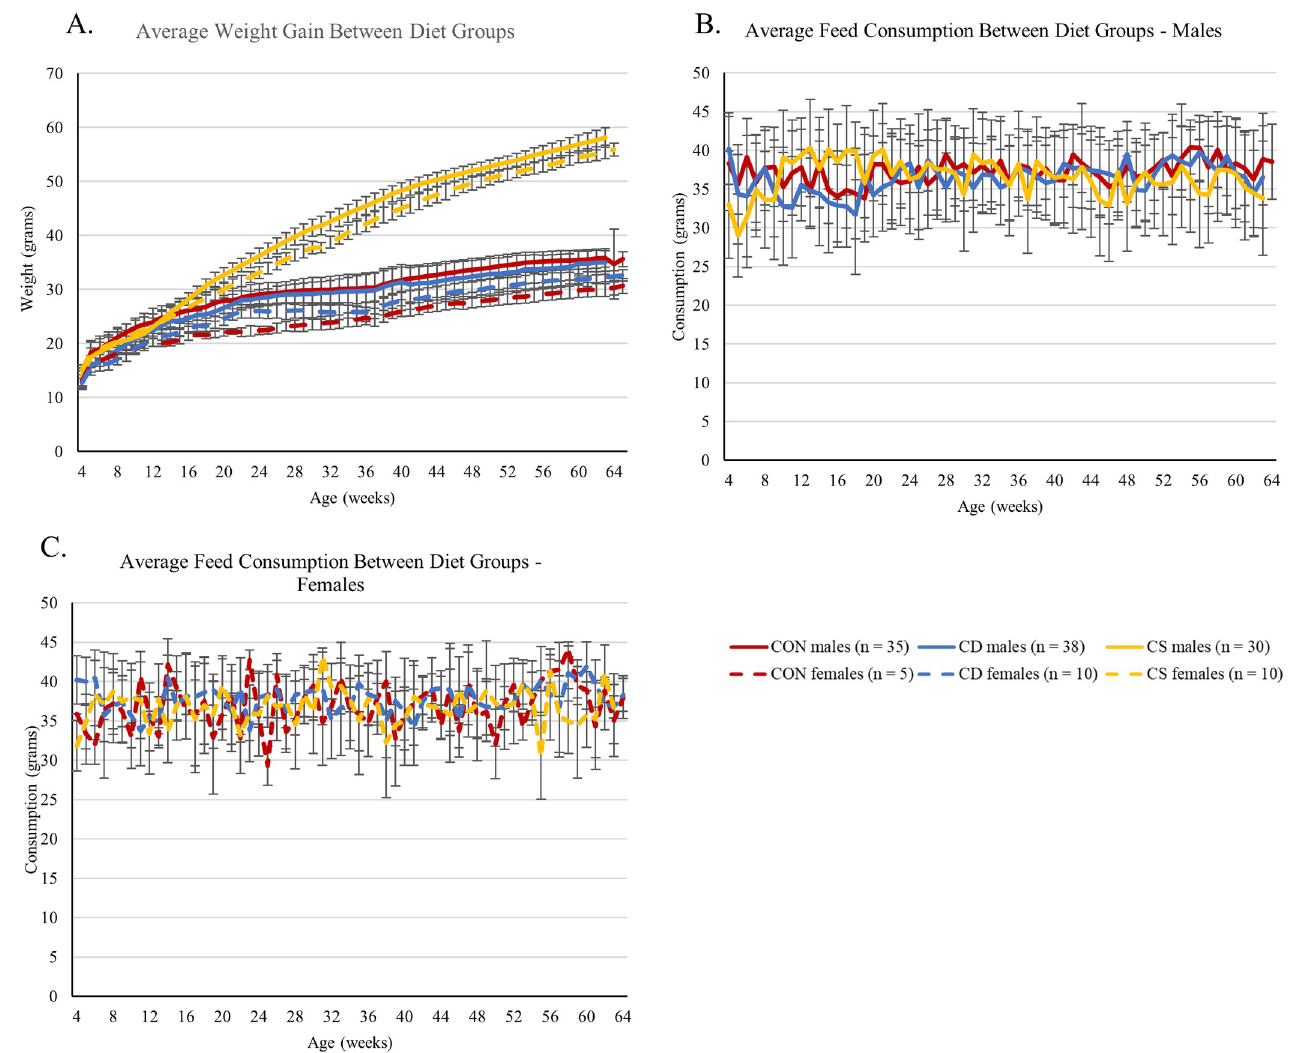
Fig 1. Weight gain and food consumption. (A) Weight gain of mice fed with the control, CD-HFFC, and CS-HFFC diets. Male and female mice fed with the CS-HFFC diet gained significantly more weight than mice fed with the control or CD-HFFC diets. Male CS-HFFC fed with mice were considered obese at 14 weeks of age while females fed with the same diet became obese at 10 weeks of age. (B) and (C) Feed consumption assessment per cage. Overall, the three groups of mice seem to be consuming the same amount of